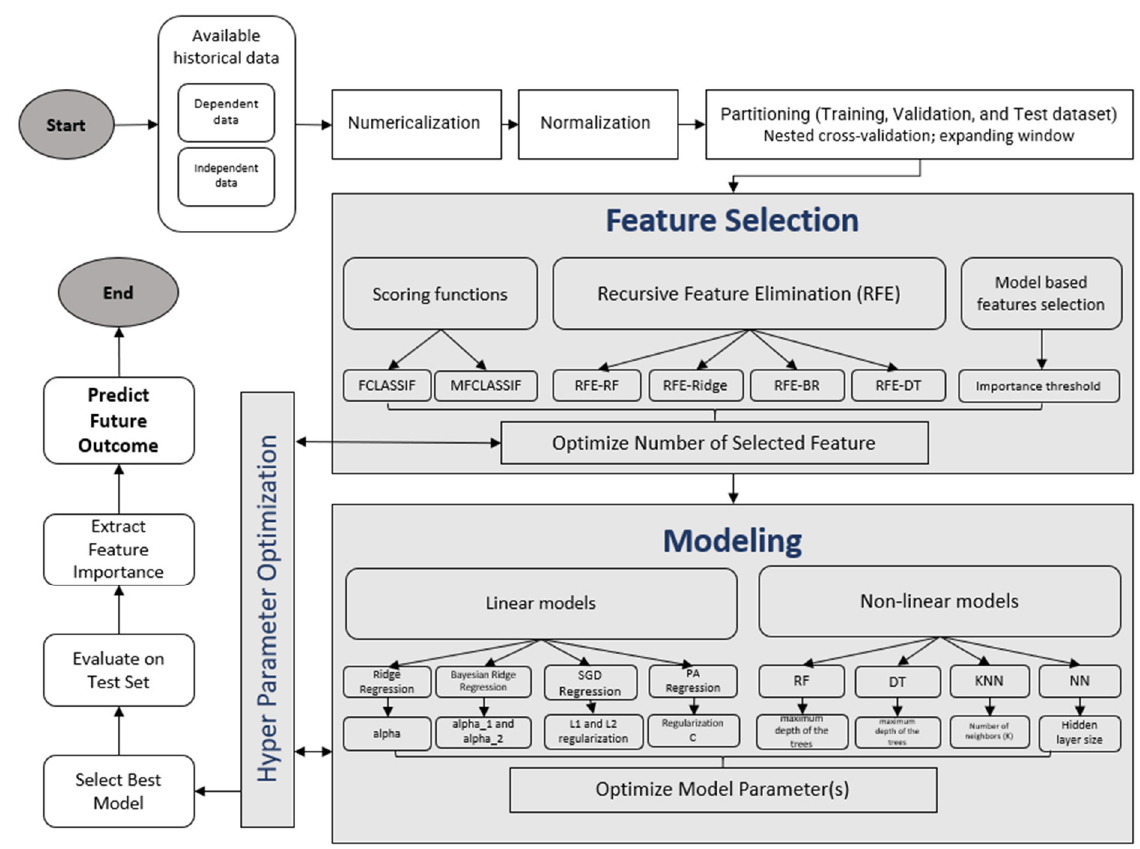
Figure 3. The pipeline of the study.